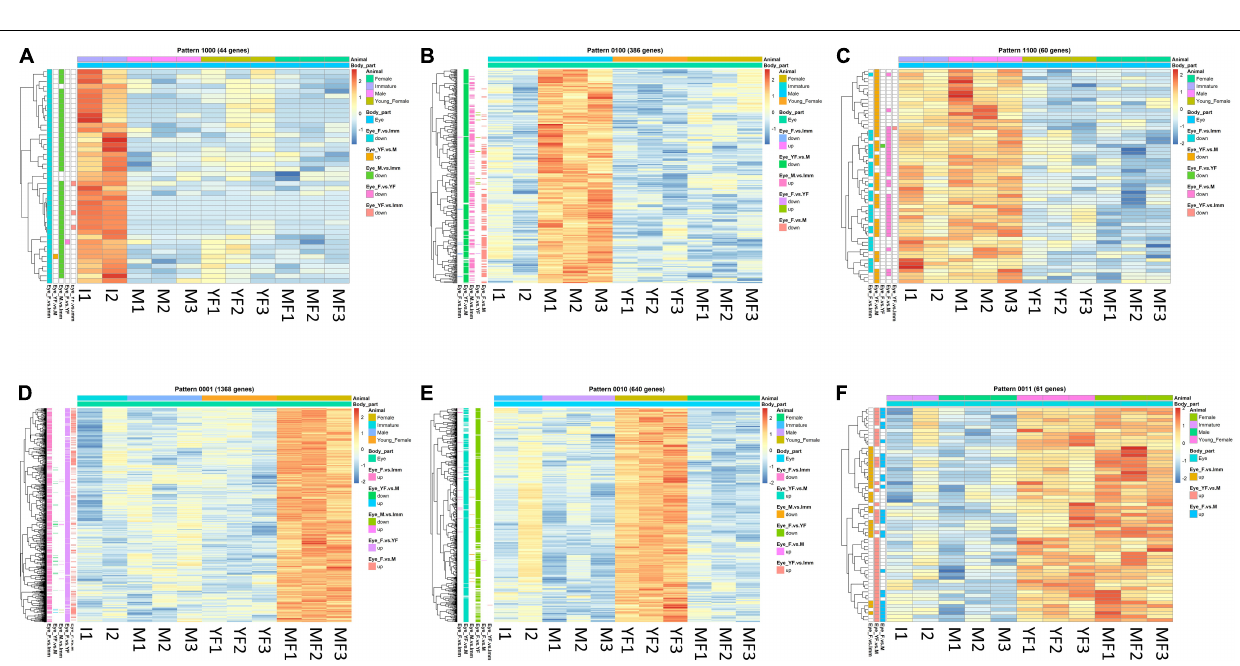
FIGURE 5 | Typical binary patterns of expression in the transcriptomic library of the Hippolyte inermis eye. Genes that were differentially expressed (DE; FDR P < 0.05, linear fold change < –1.3 or > 1.3) between any stages were unified and subjected to binary pattern analysis in which 1 = high expression and 0 = low expression. (A) 1,000 - immature specific pattern. (B) 0100 - male specific pattern. (C) 1100 - immature and male specific pattern. (D) 0001 - mature female specific pattern. (E) 0010 - young female specific pattern. (F) 0011 - young female and mature female specific pattern. I = immature, M = male, YF = young female, MF = mature female. A list of all DE genes that matched any binary pattern can be found in Supplementary Table S1 .